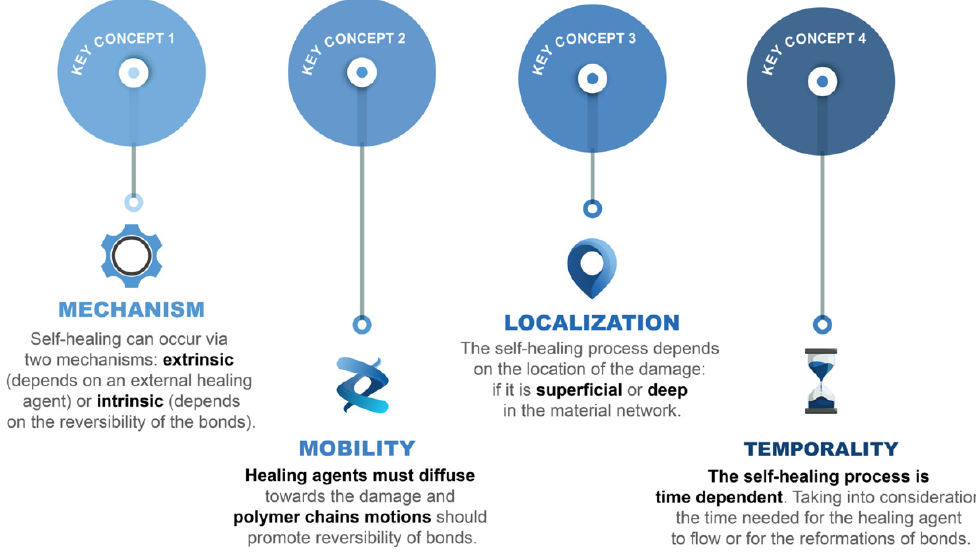
Figure 2. Self-healing key concepts. Adapted with permission from [49]. 2020, Royal Society of Chemistry.